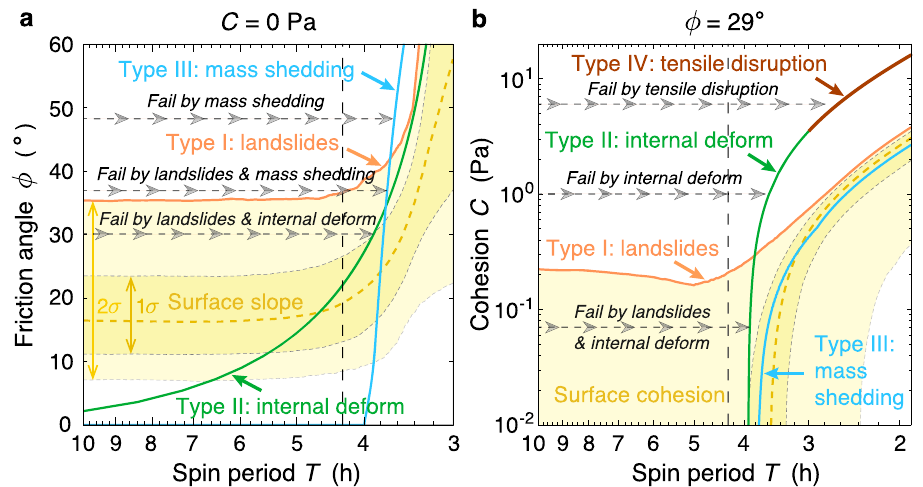
Fig. 4 | Bennu-shaped rubble-pile failure-mode diagram. Failure spin periods of the four failure types as functions of the material friction ( a , where C =0 Pa) and cohesion( b ,where ϕ =29 ∘ )areshownbythesolidcurveswithdifferentcolours(see Methods Section Theoretical failure conditions for the procedure to generate this diagram). The grey horizontal dashed lines with arrowheads represent some pos- sible evolutionary pathways of rubble piles during YORP-induced spinup. Depending on the material properties, a rubble pile would end up reaching dif- ferent failure curves, where its structure would fail via the corresponding failure typesasindicatedbythegreytext.Thedistributionsofsurfaceslopesandcohesion of the Bennu-shaped rubble pile are shown as the median (i.e., the dashed yellow